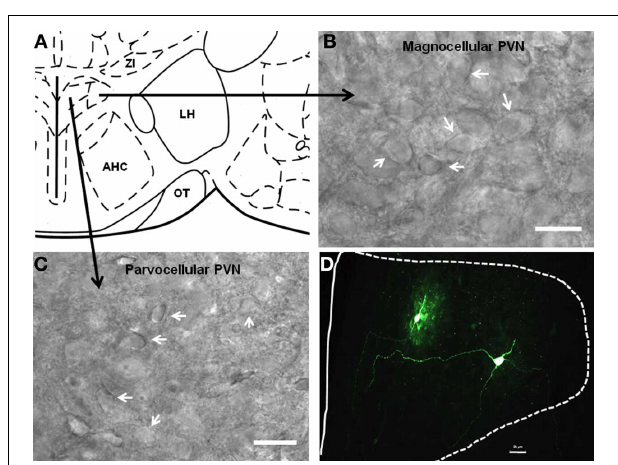
FIGURE 3 | Localization of parvocellular and magnocellular neurons in the PVN. (A) A schematic diagram showing the recording sites from the PVN neurons. (B,C) Representative images showing the cytoarchitecture of magnocellular and parvocellular neurons under DIC illumination. (D) Immunofluoroscenceimage showing two anatomically reconstructed PVN neurons, one parvocellular and one magnocellular. Scale bar 25 μ m.